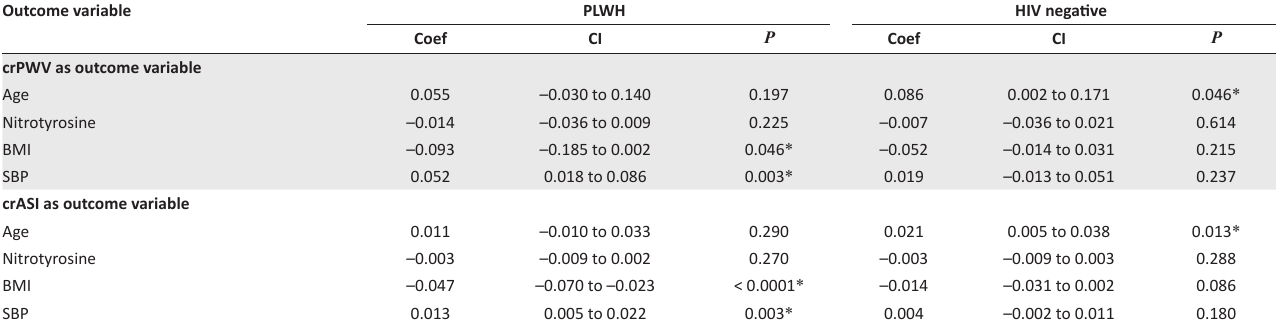
TABLE 2 : Multiple linear regression analyses of arterial stiffness and oxidative stress. Outcome